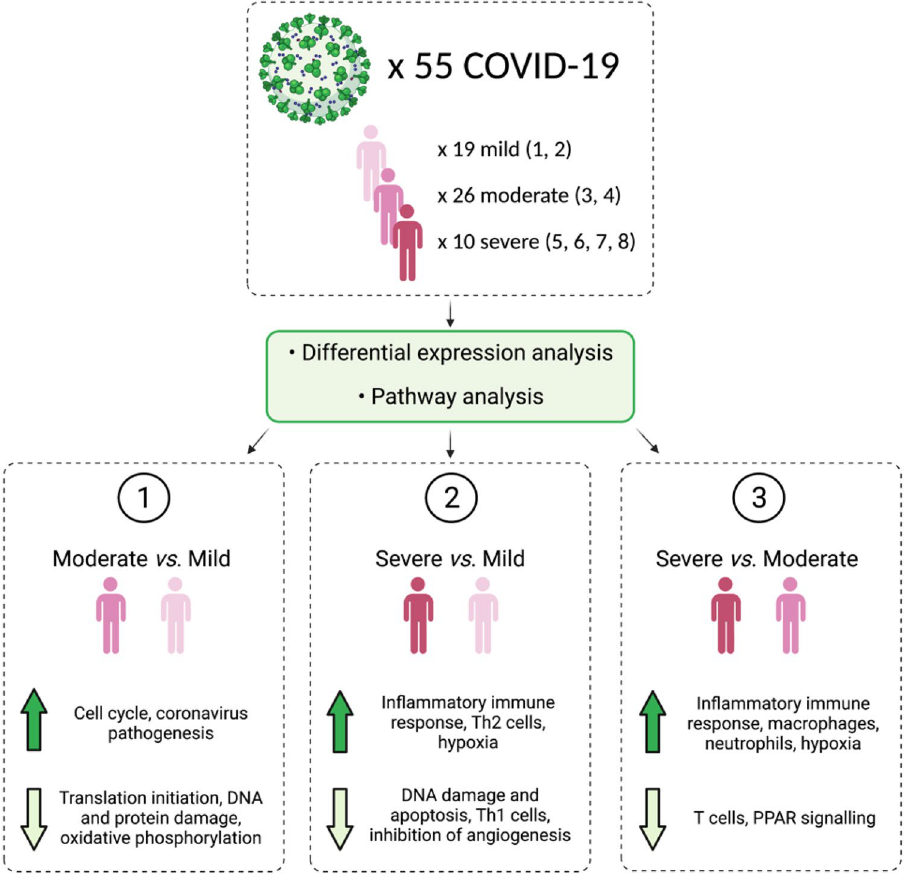
Figure 1. A schematic summarising the number of patients analysed, the main analysis steps, and the key findings. The numbers in brackets following mild, moderate, and severe are the WHO severity scores that make up these classifications. Figure made with BioRender (https:// biore nder.